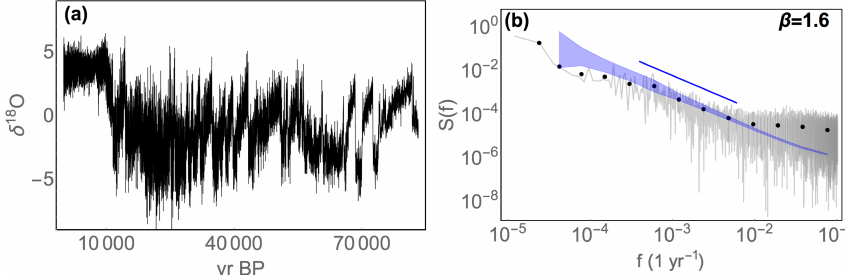
Figure 13. (a) δ 18 O anomalies from the past 85kyr of the high-resolution GRIP ice core. (b) Periodogram for the same time series.